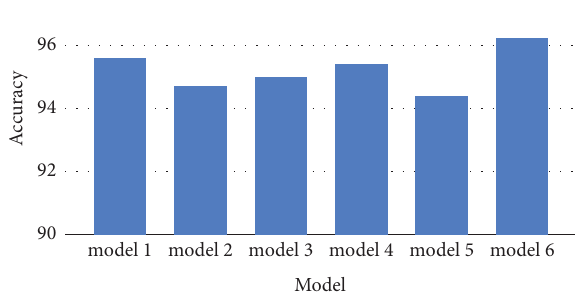
Figure 18: Accuracy of the diferent models.